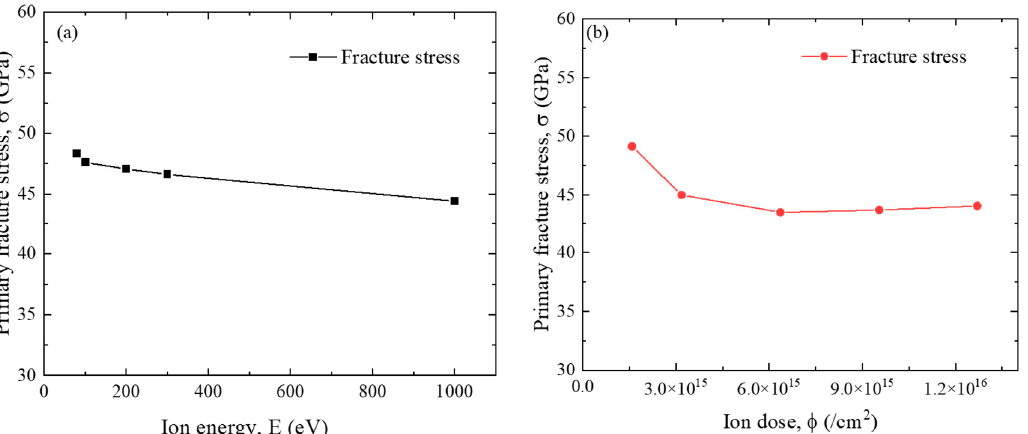
Figure 12. Influence of the ( a ) irradiation energy and ( b ) ion dose on the primary mechanical strength of G/M heterostructure. The ion dose for ( a ) is 1.27 × 10 16 /cm 2 and the ion energy for ( b ) is 200 eV, respectively.